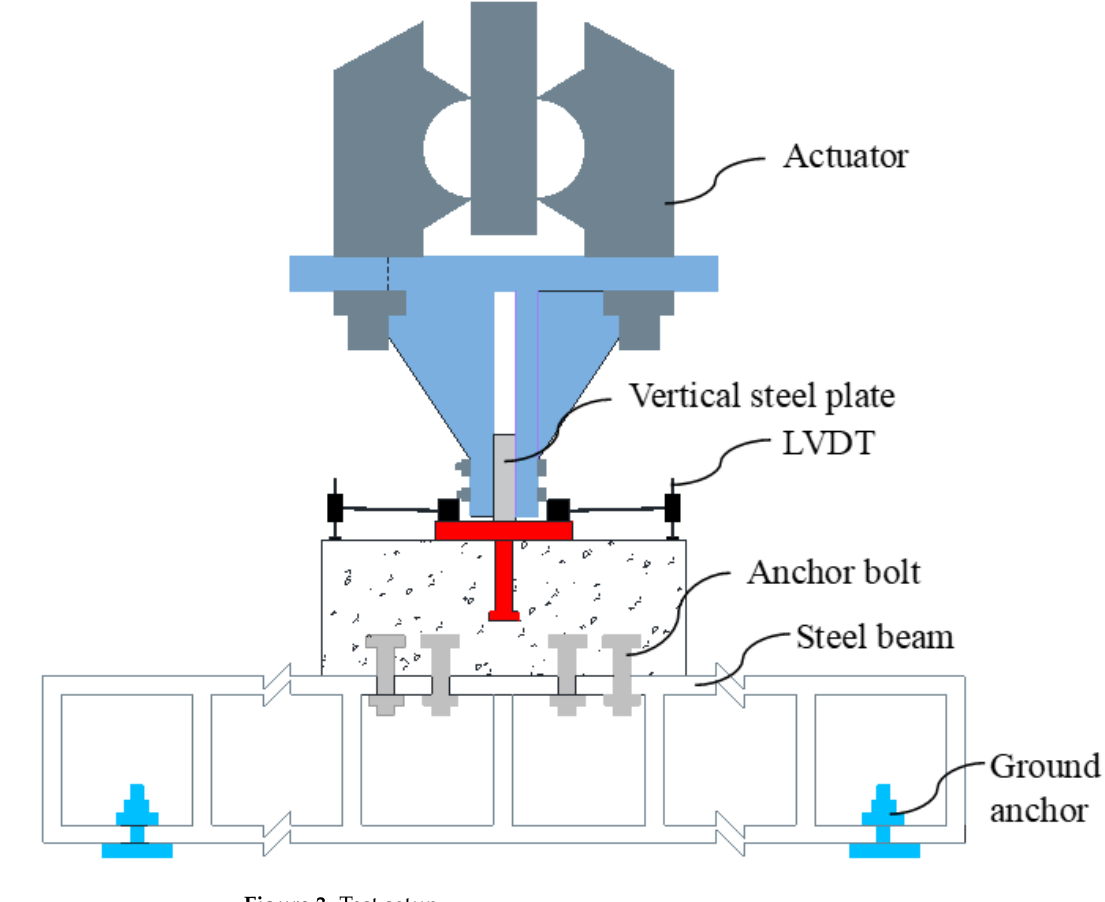
Figure 3. Test setup.